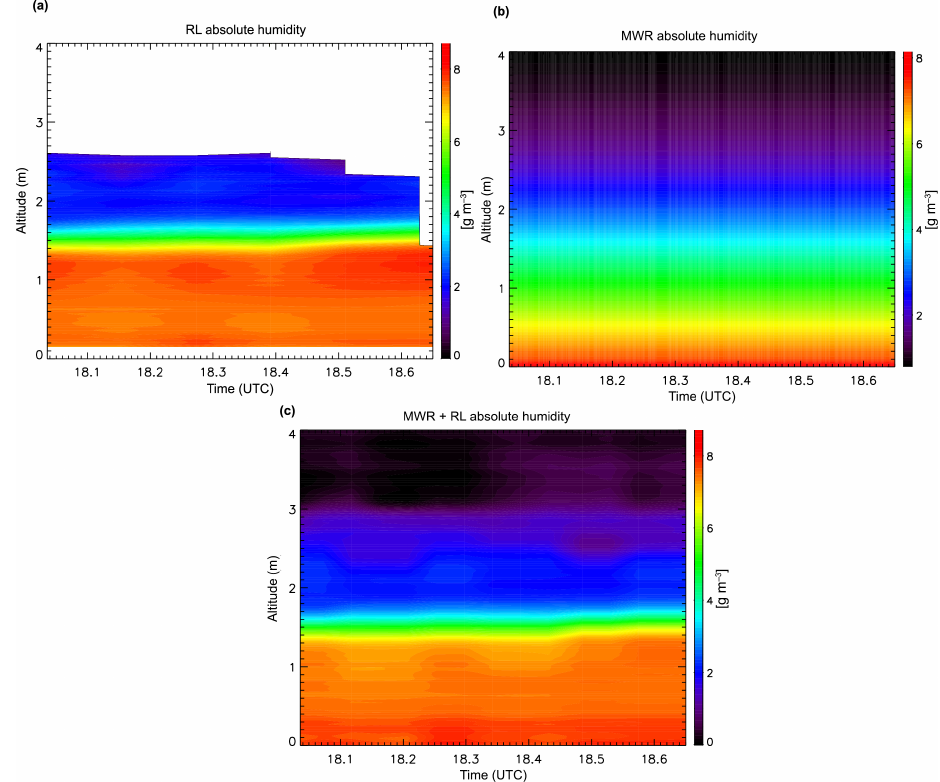
Figure 4. From left to right and top to bottom, absolute humidity (gm − 3 ) time series of RL, MWR statistical retrieval and MWR+RL